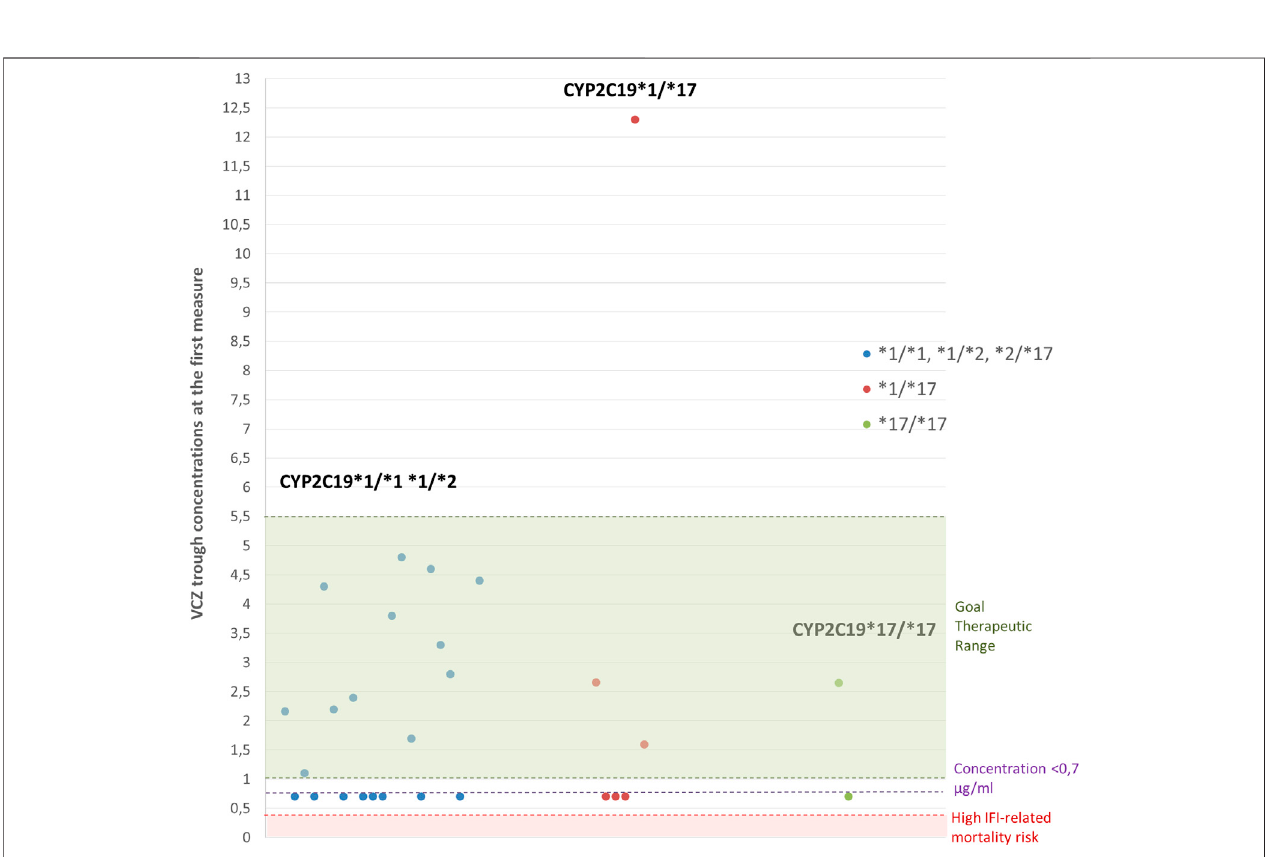
FIGURE 2 | VCZ trough concentrations obtained at the fi rst measure after initial dose adjustment based on PGx. Green area represents target therapeutic range (1 – 5.5 μ g/ml). The red area ( < 0.35 μ g/ml) represents a high-risk area of IFI-related mortality (Miyakis et al., 2010). N (cid:1) 28 patients.